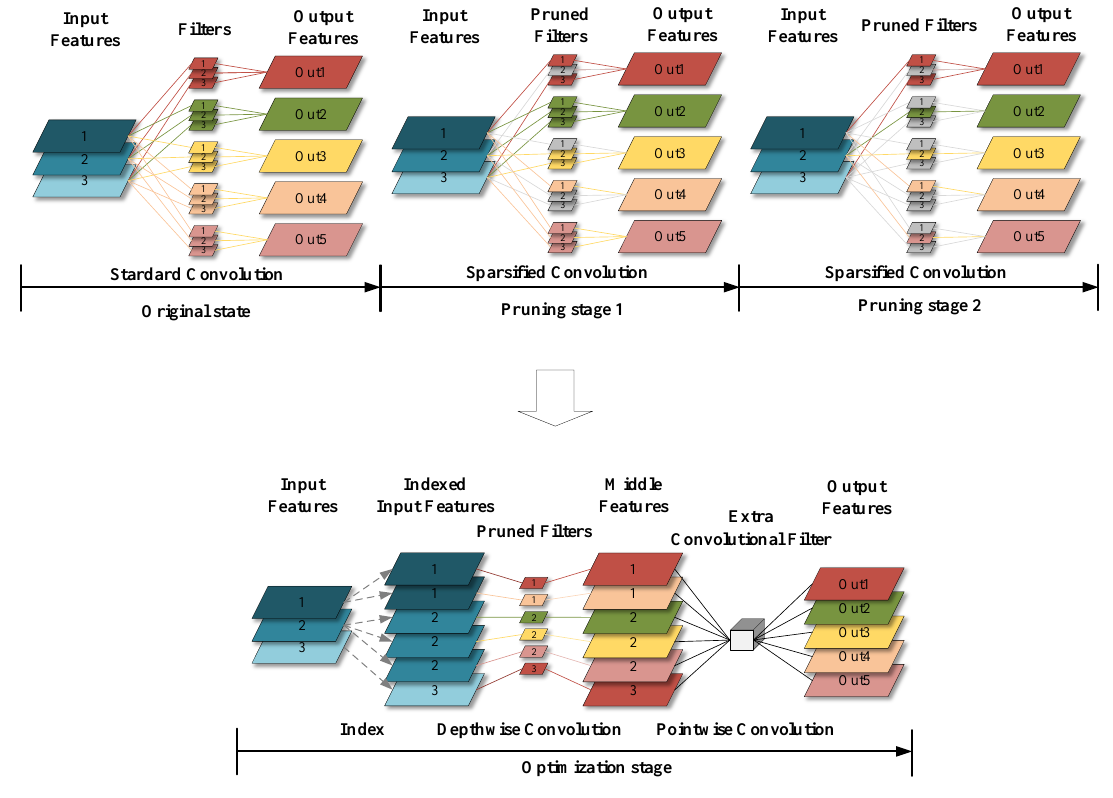
Figure 1. The illustration of the LdsConv with a input channel of R = 3, an output channel of O = 5, a group cardinality of N O = 5, a group number of G = 1, a pruning factor of k = 2 and a stage factor of s = 2. At the end of picking stages, we remove filters with the number of ( N O − k ) R . After the picking stages, an additional 1 × 1 standard convolution is added into the convolutional module to form a standard depthwise separable